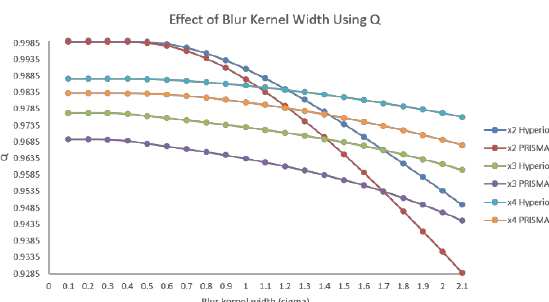
Figure 4. Effect of Blur Kernel Width Using Q on IBP’s Performance